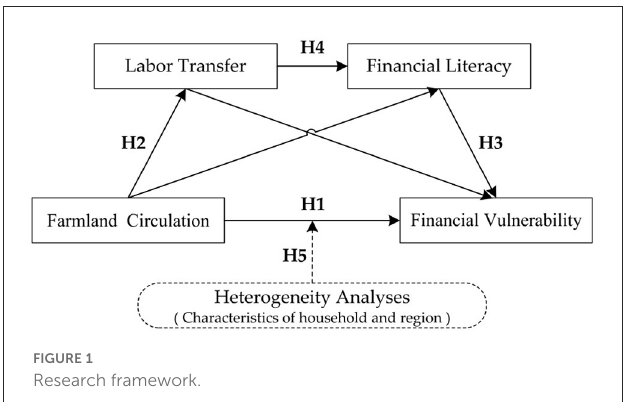
FIGURE1 Research